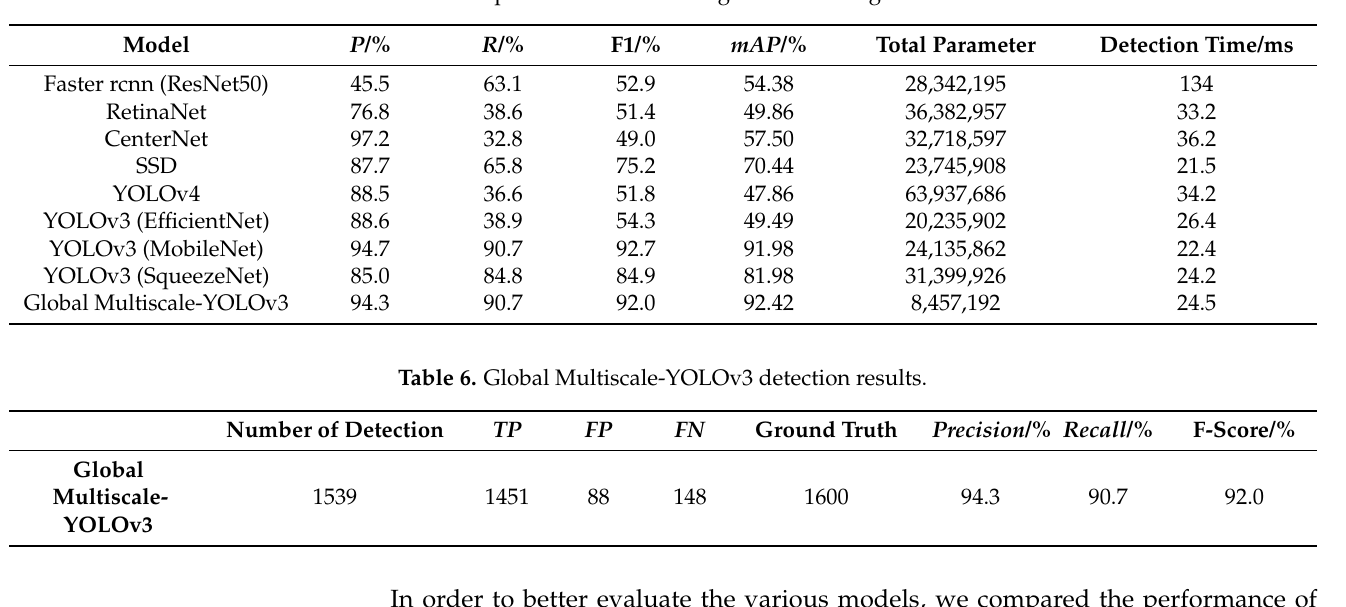
Figure 9. Change curve of loss value. Table 5. Comparison of different target detection algorithms.